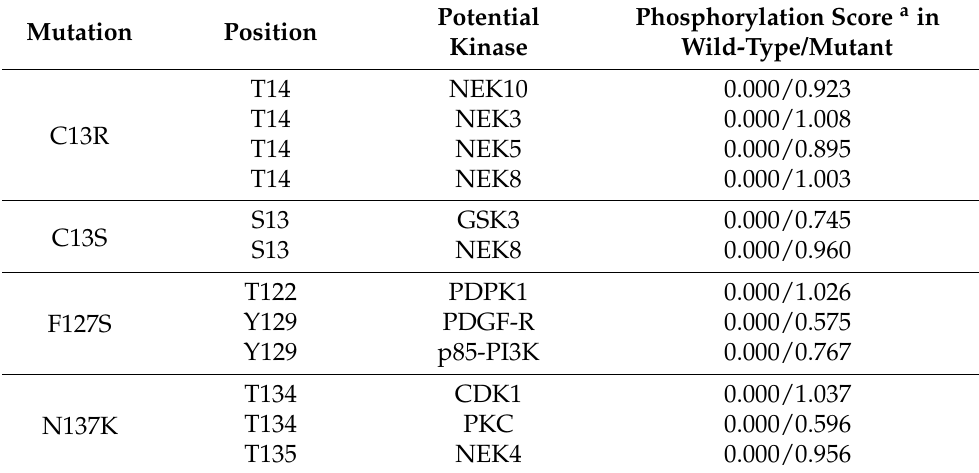
Table 3. NS5A domain-1 mutations associated with the acquisition of novel phosphorylation sites by the in silico prediction